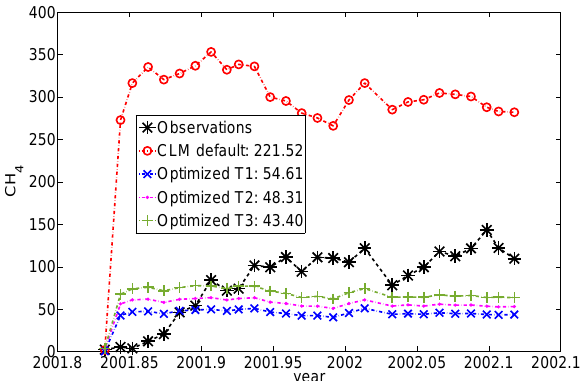
Figure 9. CH 4 emission observations and predictions when using the optimized parameters of optimization trials T1, T2, and T3, re- spectively, and when using the default parameters for the rice paddy site Central Java, Indonesia, for the real data case with d = 11 pa- rameters. The legend shows the lowest RMSE value found in each